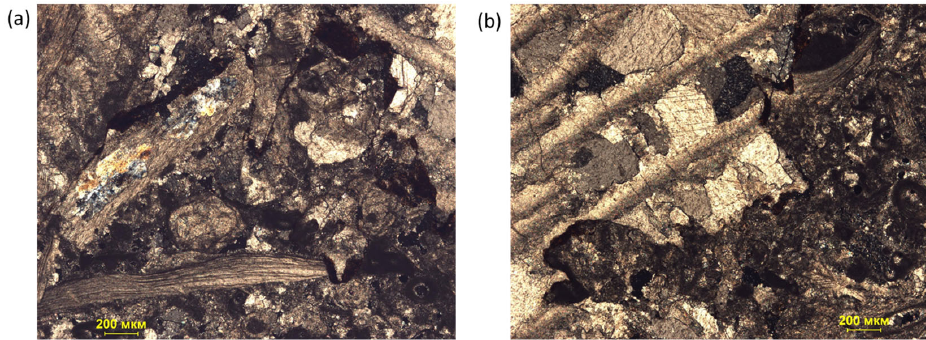
Figure 3. Microphotographs of thin sections of two samples: ( a ) fragment sectioned with an analyzer depicting brachiopod shells; ( b ) fragment of a bryozoan, the chamber of which is filled with medium- grained calcite.